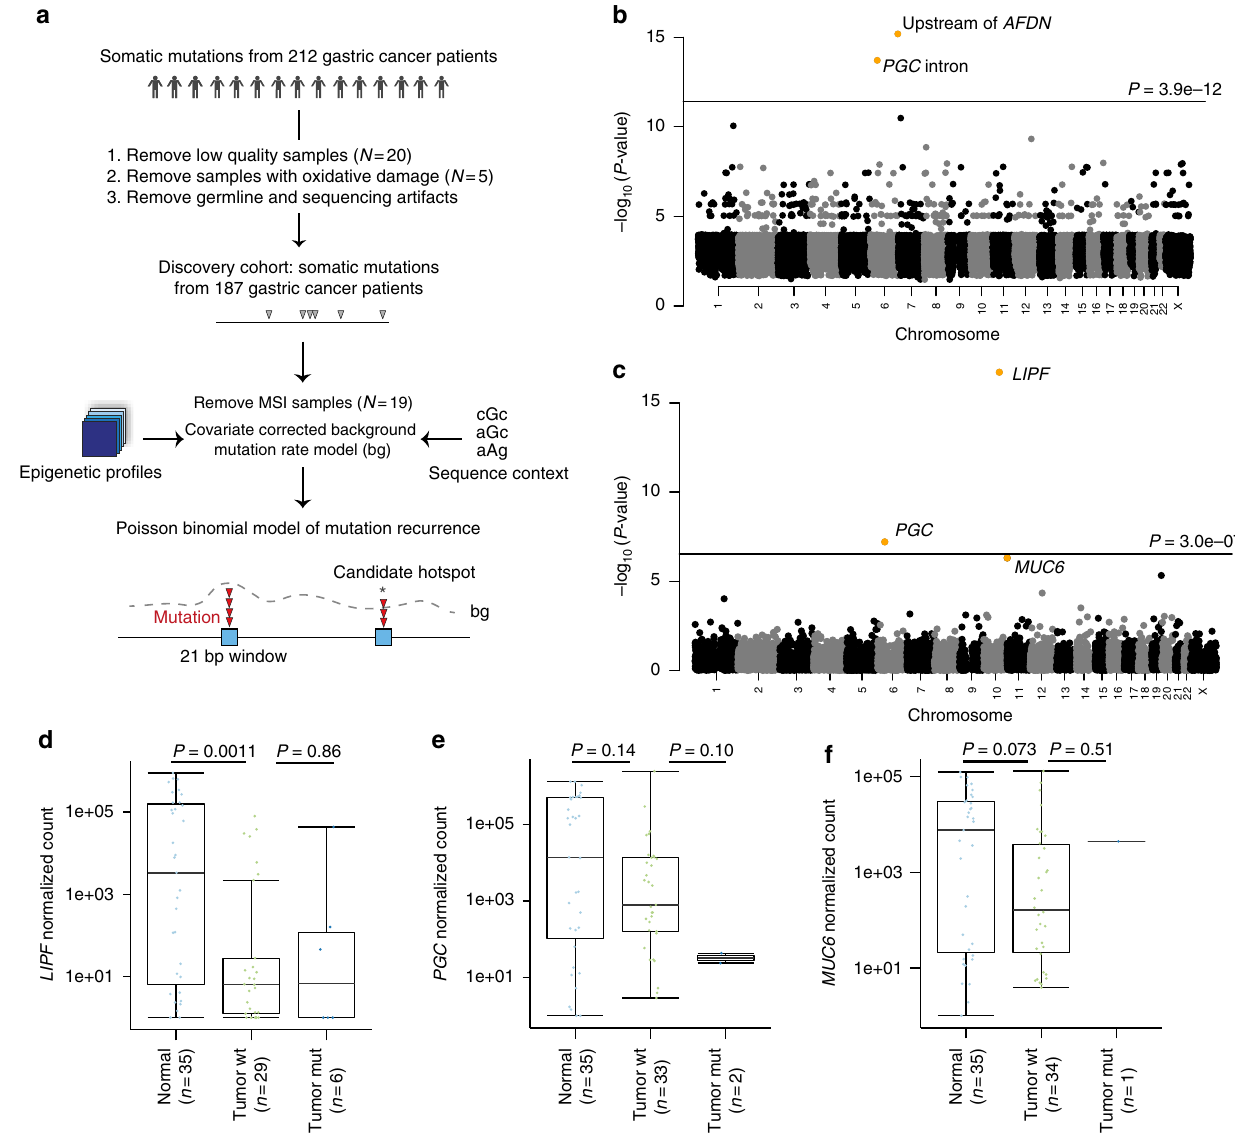
Fig. 2 Genome-wide analysis of non-coding indel recurrence. a Work fl ow of the method to detect recurrently mutated non-coding regions. b Genome-wide negative log P -values of indel recurrence of 21 bp regions with at least one indel. The horizontal line marks the Bonferroni adjusted P -value of 0.01. c Negative log P -value of indel recurrence in merged non-coding regions of each gene. The top three signi fi cantly mutated genes are highlighted. The horizontal line marks the Bonferroni adjusted P -value of 0.01. d – f Gene expression of LIPF ( d ), PGC ( e ), and MUC6 ( f ) in normal gastric samples, tumors wildtype for the gene of interest, and tumors with non-coding indels in the gene of